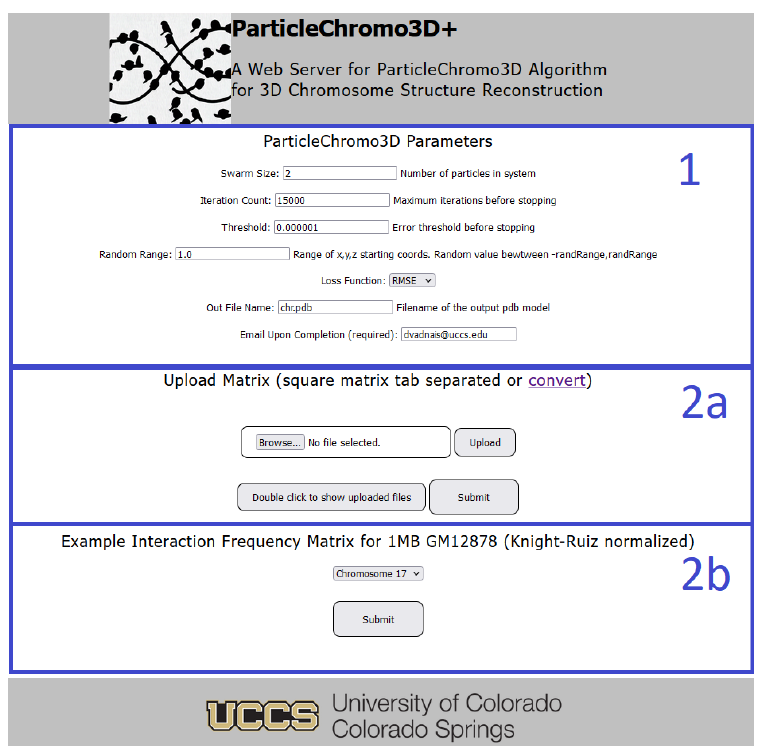
Figure 4. Graphical user interface screenshot for the ParticleChromo3D+